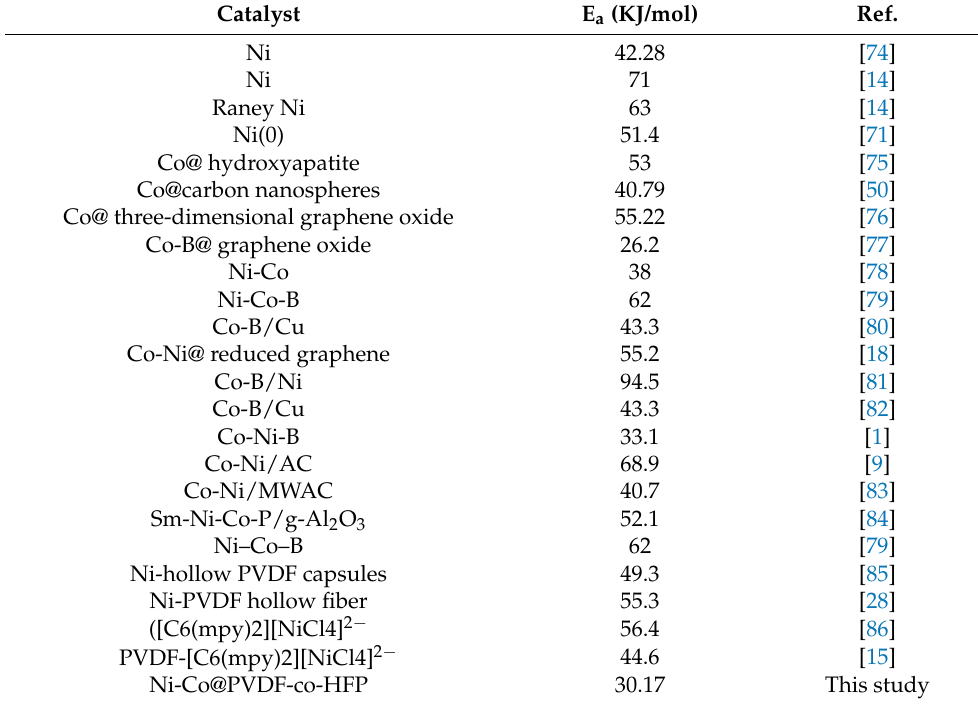
Table 1. Ea of membrane NFs, Ni, and Cu-based catalysts for the dehydrogenation of SBH.